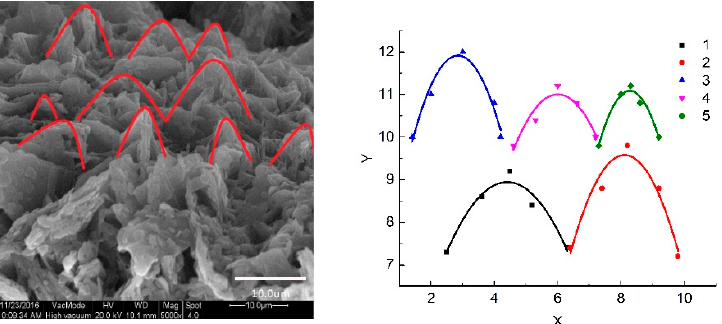
Figure 7. Microscopic morphology fitting curve of membrane SEM.